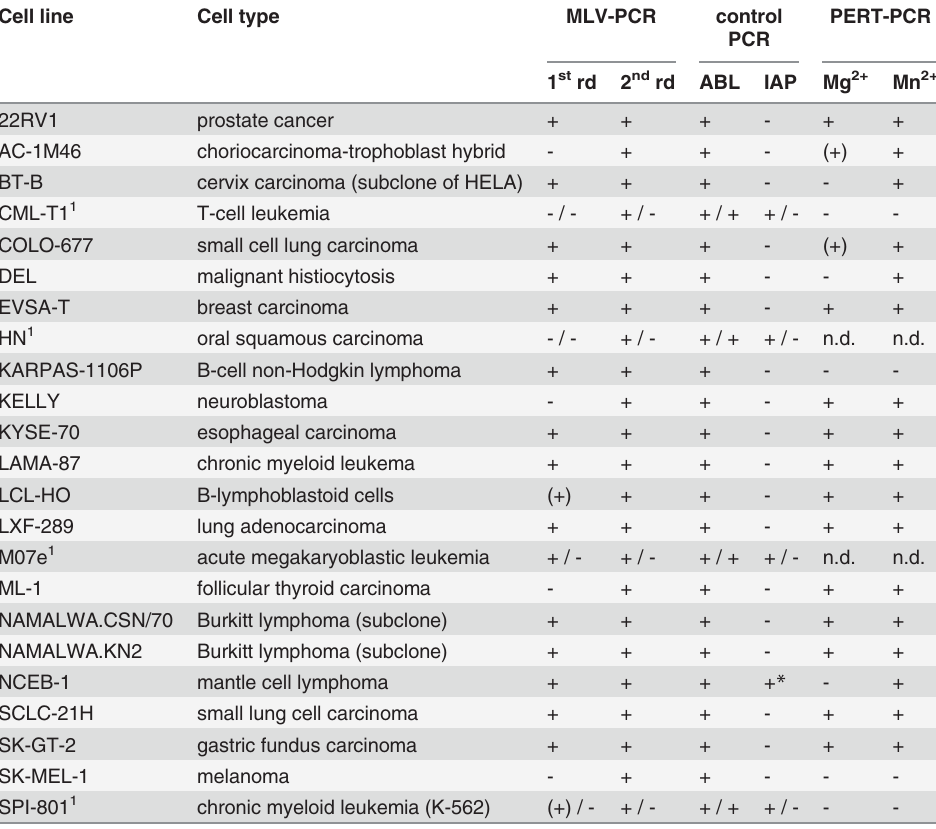
Table 2. MLV-positive cell lines tested by nested PCR and PERT-PCR